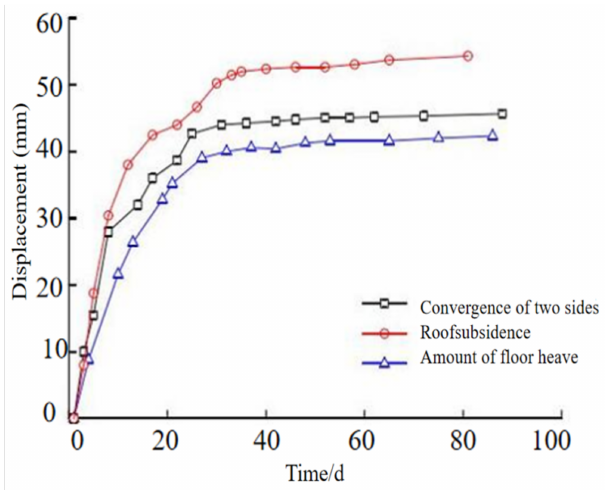
Figure 18. Schematic diagram of roadway surrounding rock